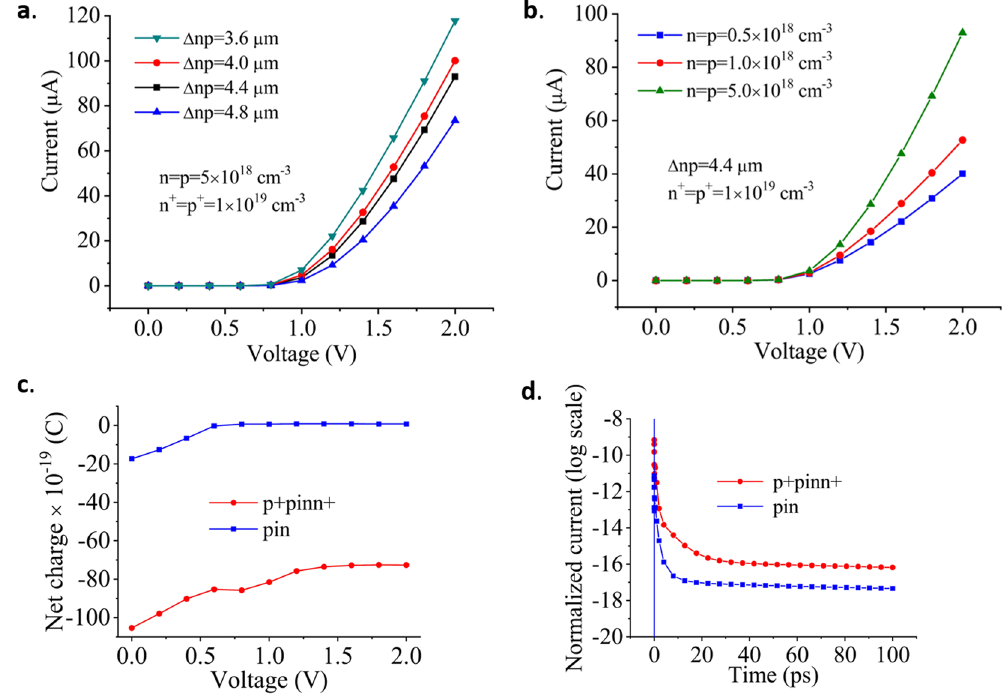
Figure 7. ( a ) I-V characteristic as a function of the distance between doping regions for constant doping densities. ( b ) I-V characteristic as a function of doping densities at a constant distance between doping regions. ( c ) Net charge as a function of the applied voltage. ( d ) The transient analysis provides time constants of 0.313 ns and 0.148 ns, for pin and p + pinn + configuration, respectively, corresponding to a bandwidth of 0.508 GHz and 1.07